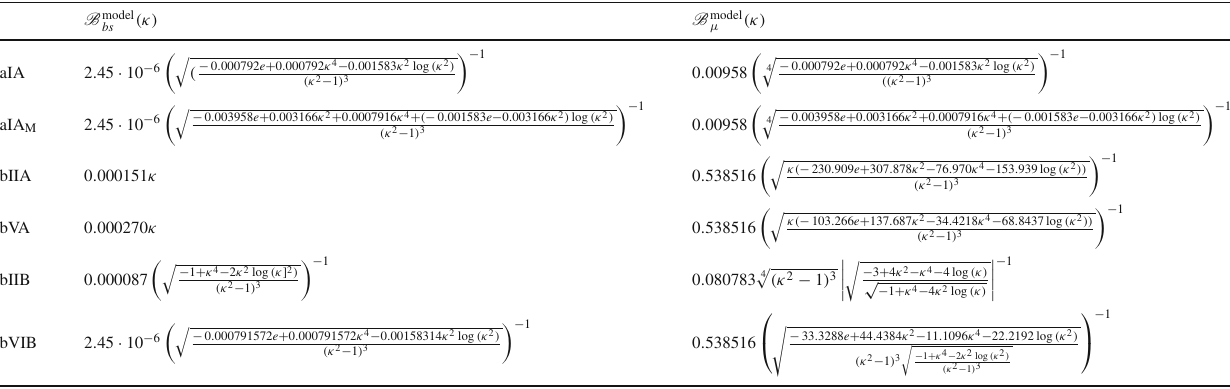
Table 6 Presented here are the constraints on new Yukawa coupling Γ μ and the product Γ s Γ ∗ from B - ¯ B -mixing and thus a lower bound on Γ μ from R K on Γ s Γ ∗ b B model (κ) B model μ (κ) bs